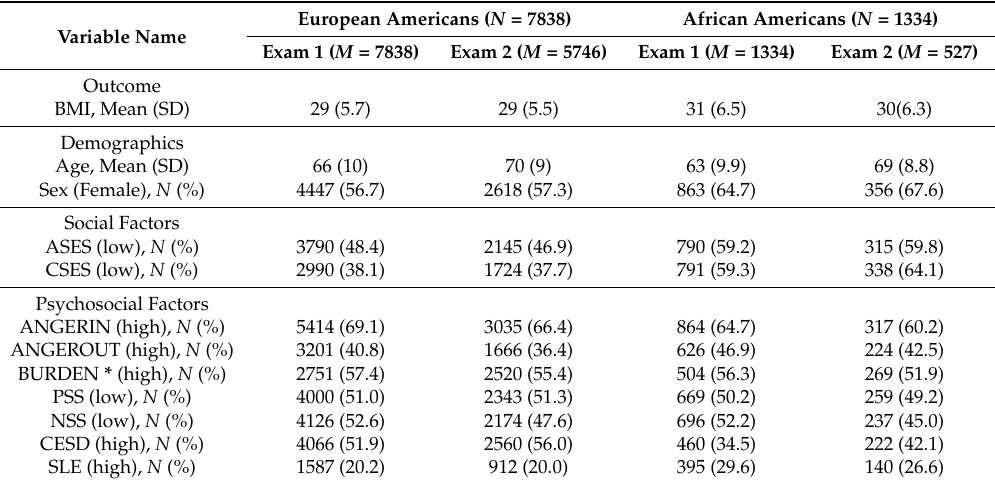
Table 1. Descriptive statistics of the social/psychosocial factors and covariates in the Health and Retirement Study